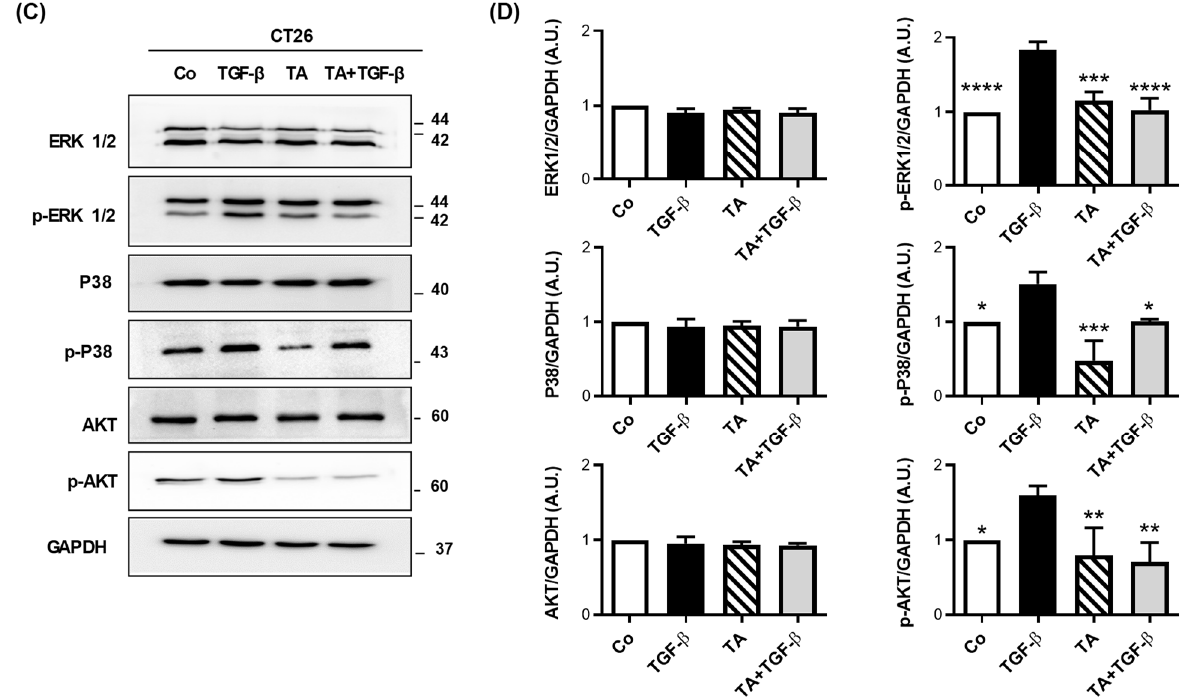
Figure 7. TA blocks TGF- β -induced non-Smad-dependent signaling pathways in SW480 and CT26 cells. Serum-starved SW480 and CT26 cells were treated with TA (0.8 µ M), TGF- β (10 ng/mL), or a combination of both (TA + TGF- β ) for 48 h. Vehicle-treated cells served as the control (Co). Representative immunoblot and densitometry quantification analysis of total and phosphorylated ( p -) ERK 1/2 , P38, and AKT in SW480 ( A , B ) and CT26 ( C , D ) cells after 48 h of treatments. The band intensity was quantified using GAPDH as an internal loading control, and quantification values were normalized to the control. Results are expressed as mean ± SD of 3 independent experiments (n = 3). Statistical significance was determined by one-way ANOVA, followed by Tukey’s test for multiple comparison tests, with * p < 0.05, ** p < 0.01, *** p < 0.001, and **** p < 0.0001, vs. the corresponding TGF- β 1 group.